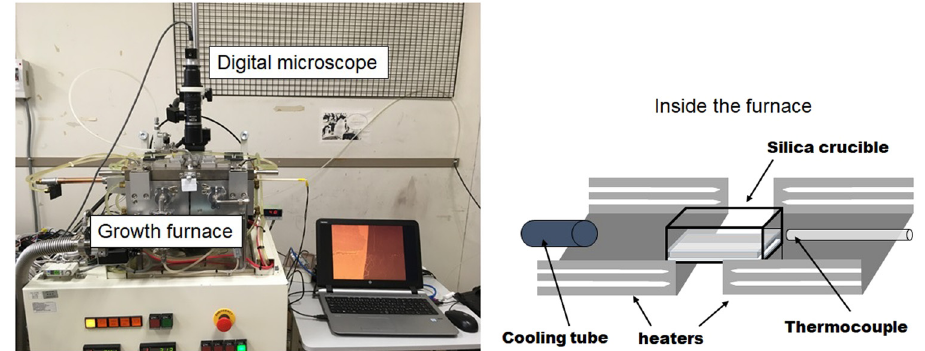
Figure 2: In situ observation system consisting of a crystal growth furnace and a digital optical microscope: ( left ) picture of the system and ( right ) schematic image of the inside of the